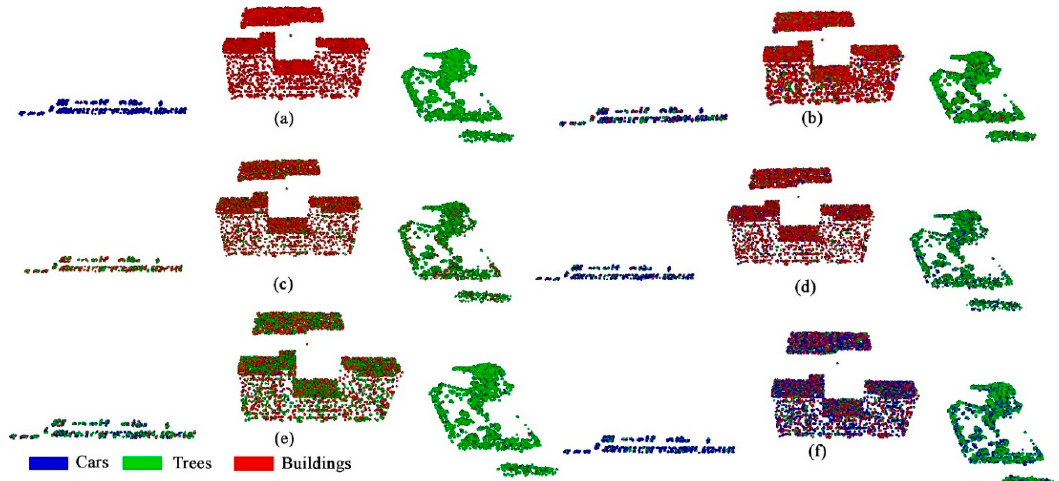
Figure 6. Classification results of ALS point clouds selected from Scene2. ( a ) Ground truth; ( b ) our method; ( c ) AWP; ( d ) AMGL; ( e ) MLAN; ( f ) NNSG.